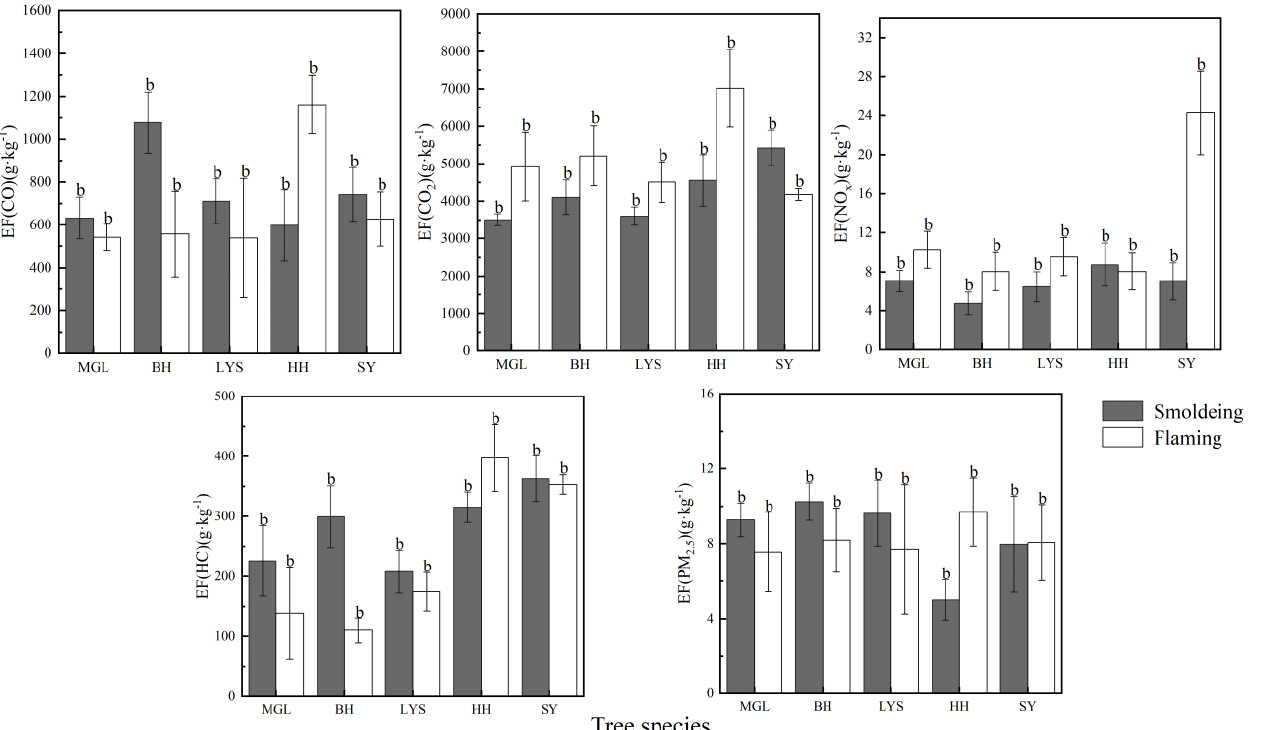
Figure 5. Emissions released by different layers of five tree species under different combustion states.Identical letters indicate no significant difference, while different letters indicate a significant difference between the treatment and the control.